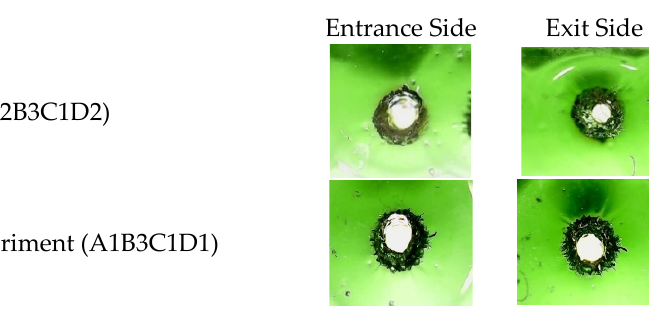
Figure 7. Comparison of the drill photos from the results with optimal combination (A1B3C1D1) and the combination used in Run 6 (A2B3C1D2).